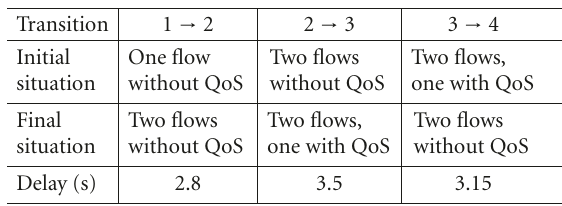
Table 4: Dynamic QoS change